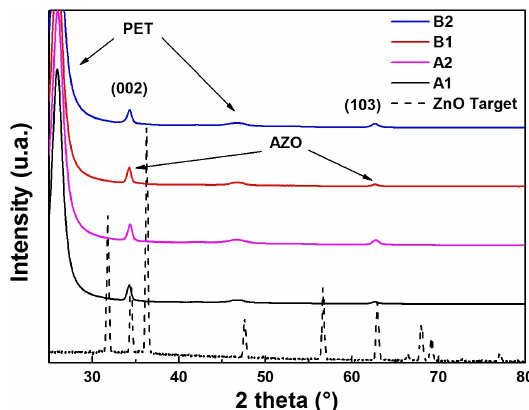
Figure 2. X-ray diffractogram of bulk ZnO bulk and of the AZO films deposited on PET. The arrows indicate the DRX peaks of the PET substrate and the (002) and (103) planes of the AZO films.